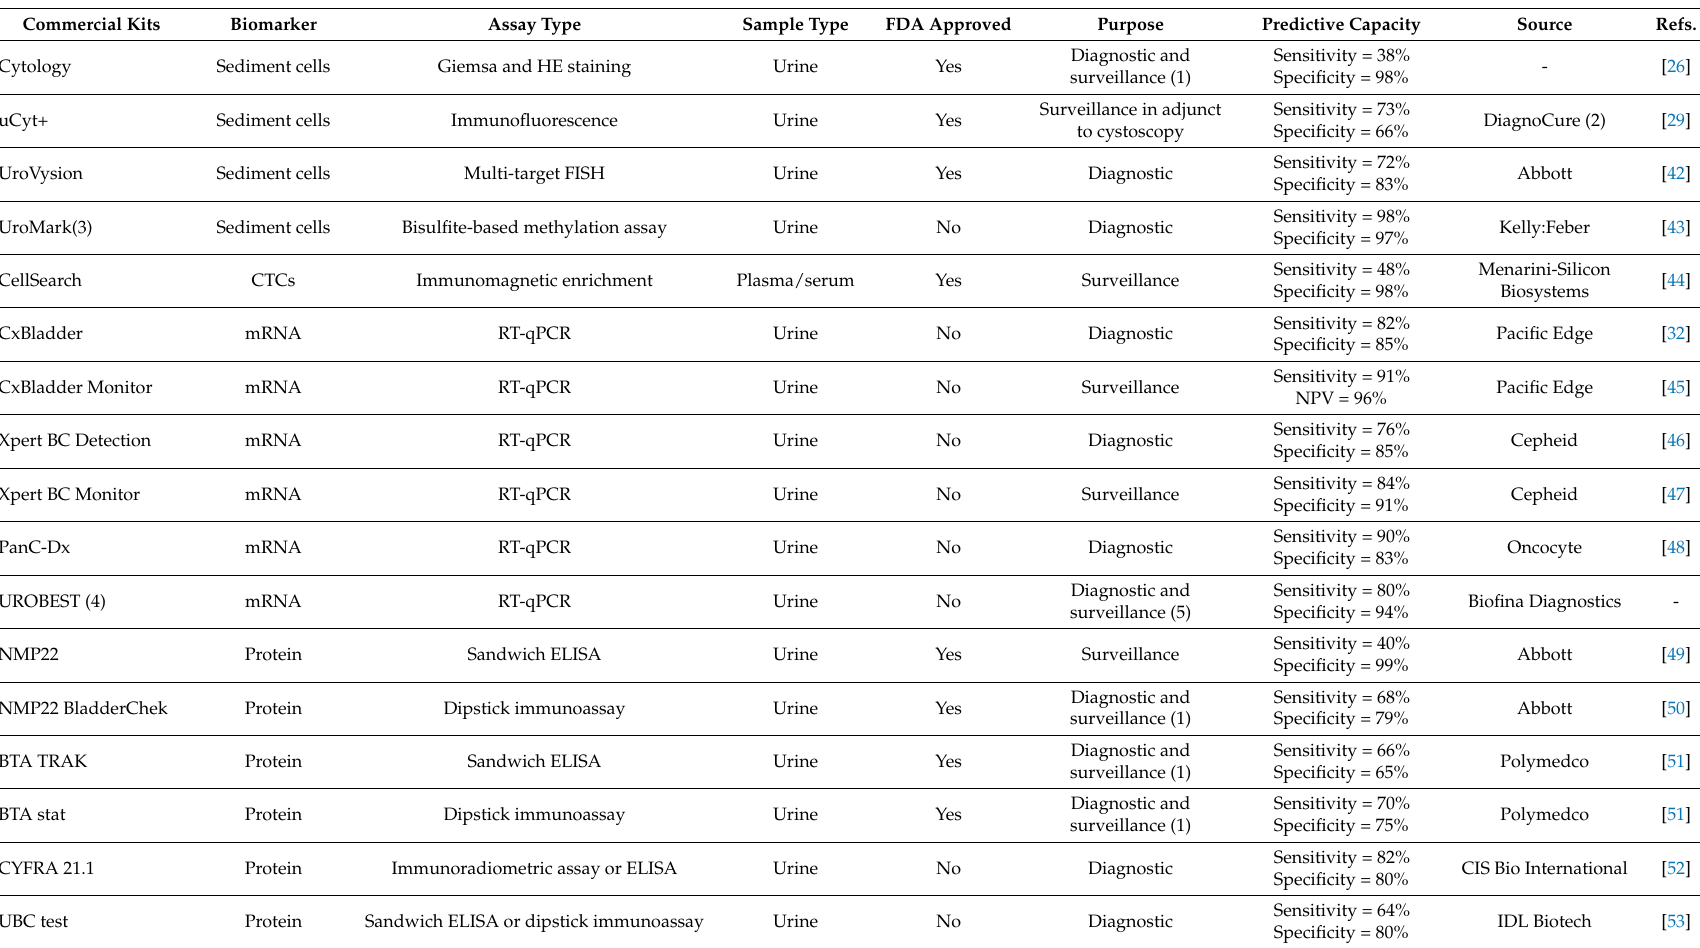
Table 1. Commercial kits to detect and follow-up bladder cancer (BC) using liquid biopsy